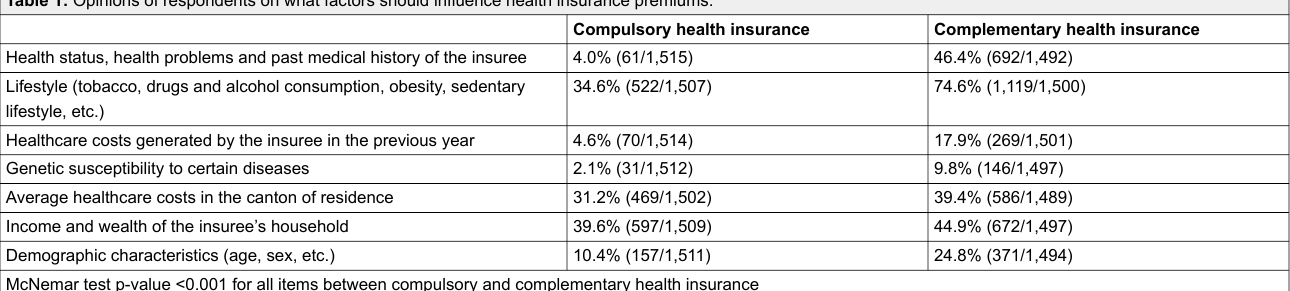
Table 1: Opinions of respondents on what factors should influence health insurance premiums.